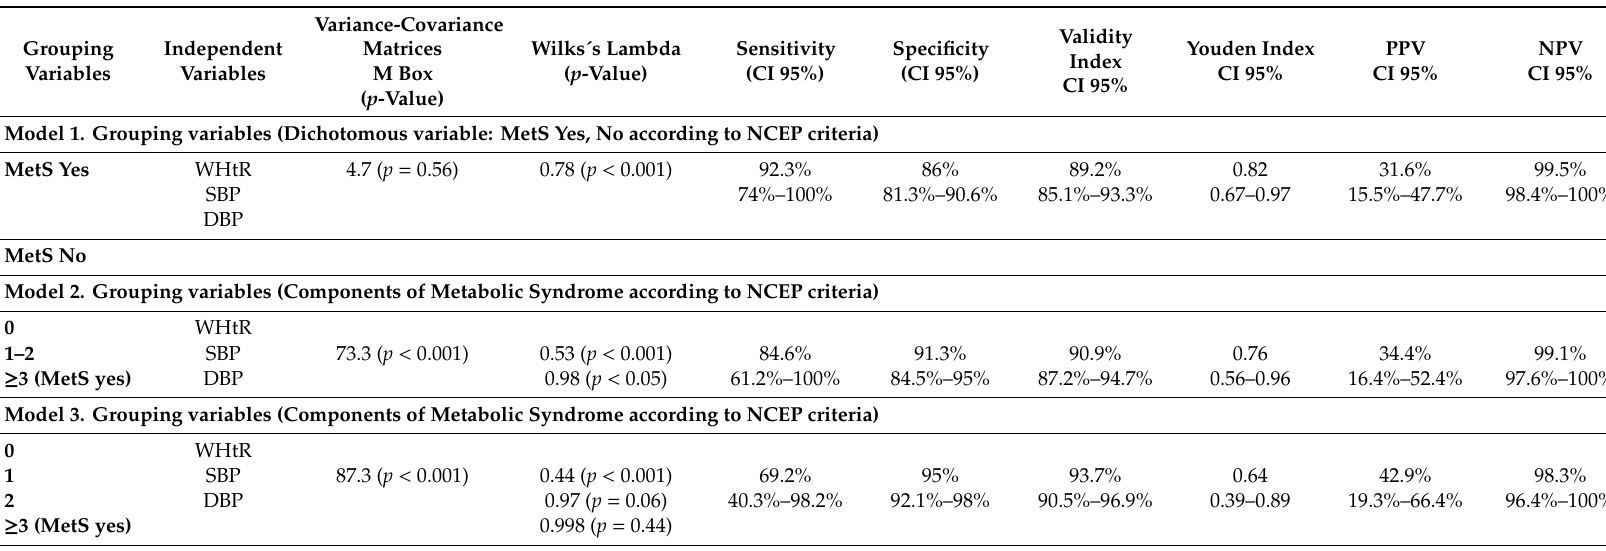
Table 4. Comparison of discriminant analysis models for NIM-MetS (Non-Invasive Method for early detection of Metabolic